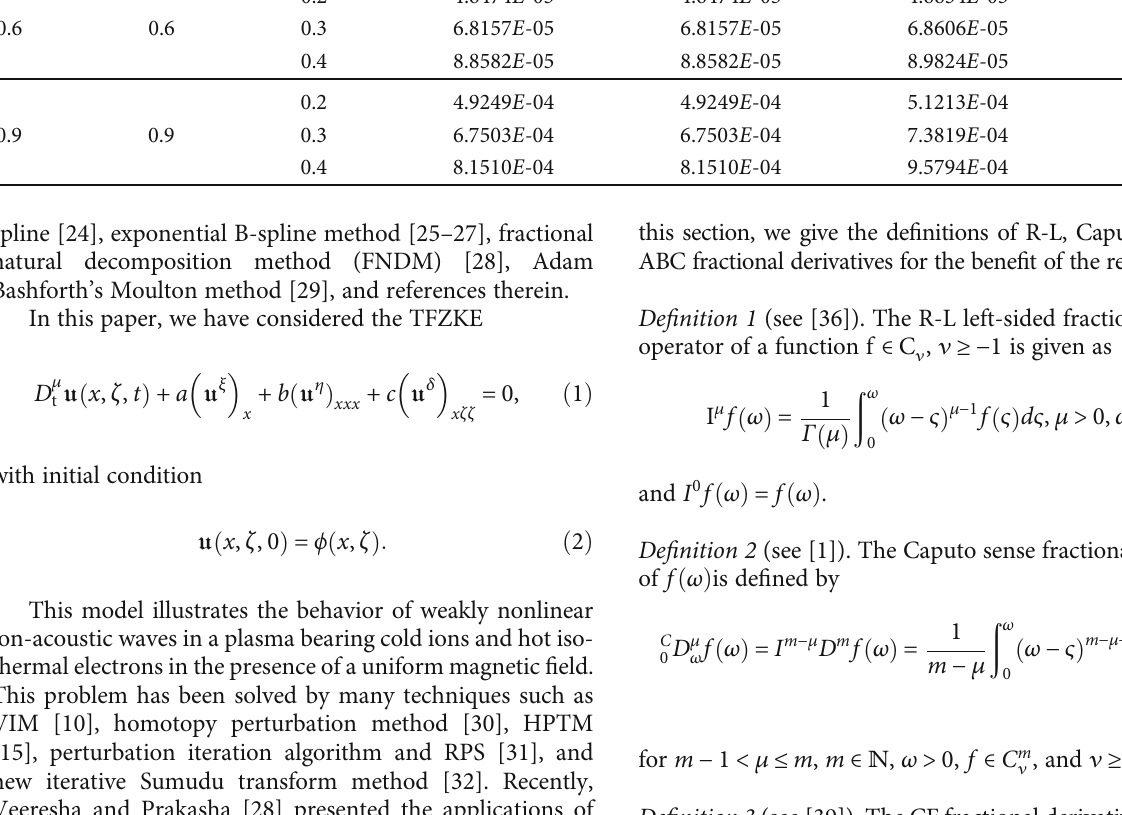
NTDM CF and ABC with PIA [31] and RPSM [31] of Example 1 for